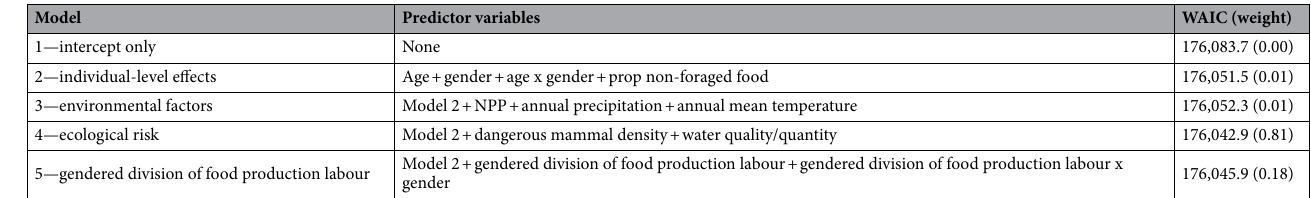
Table 2. Model summaries and comparison statistics. All models include random effects for Individual and Society. Age Early Childhood (between 3 and 6 years of age, early juveniles for the Mikea dataset—reference category), Middle Childhood (between 7 and 12 years of age, late juveniles for the Mikea dataset), Adolescence (between 13 and 18 years of age, young adults for the Mikea dataset). Gender : Girls (reference category) and Boys. Prop Non-Foraged Food proportion of diet which was domesticated foods and foods purchased and/ or traded. Gendered Division of Food Production Labour Standardized to between − 2, women do all the food production labour and 2, men do all the food production labour. NPP Net Primary Productivity in gC/m 2 /year. Annual Precipitation In mm. Annual Mean Temperature In °C. Dangerous Mammal Density Low/High. Water Quality/Quantity Four-point